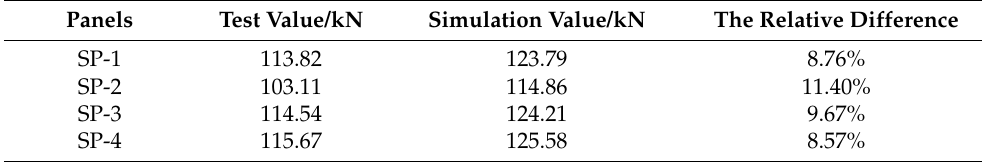
Table 5. Test and simulation values of ultimate load.